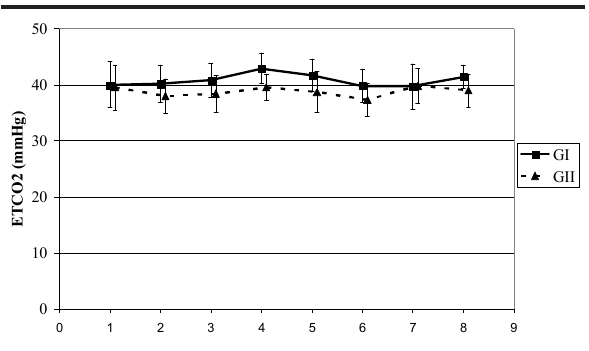
concentration 2